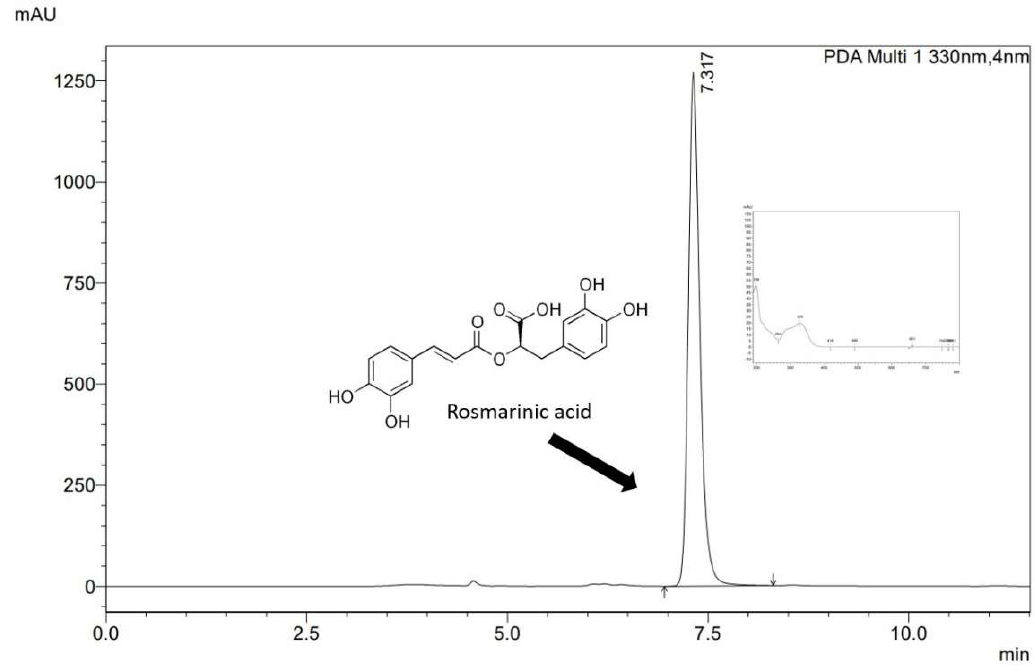
Figure 1. The chromatogram of RA.